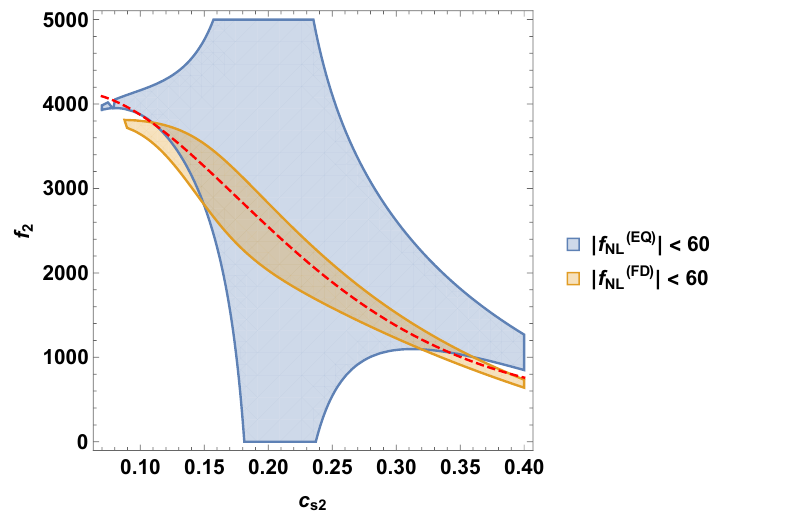
Figure 6 . A plot showing the existence of a common region of small sound speed c s 2 with equilateral and folded shapes both within the CMB constrains. The red-dashed line represents the f in eq.